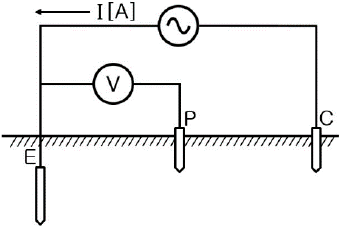
Figure 1. Fall-of-potential method.